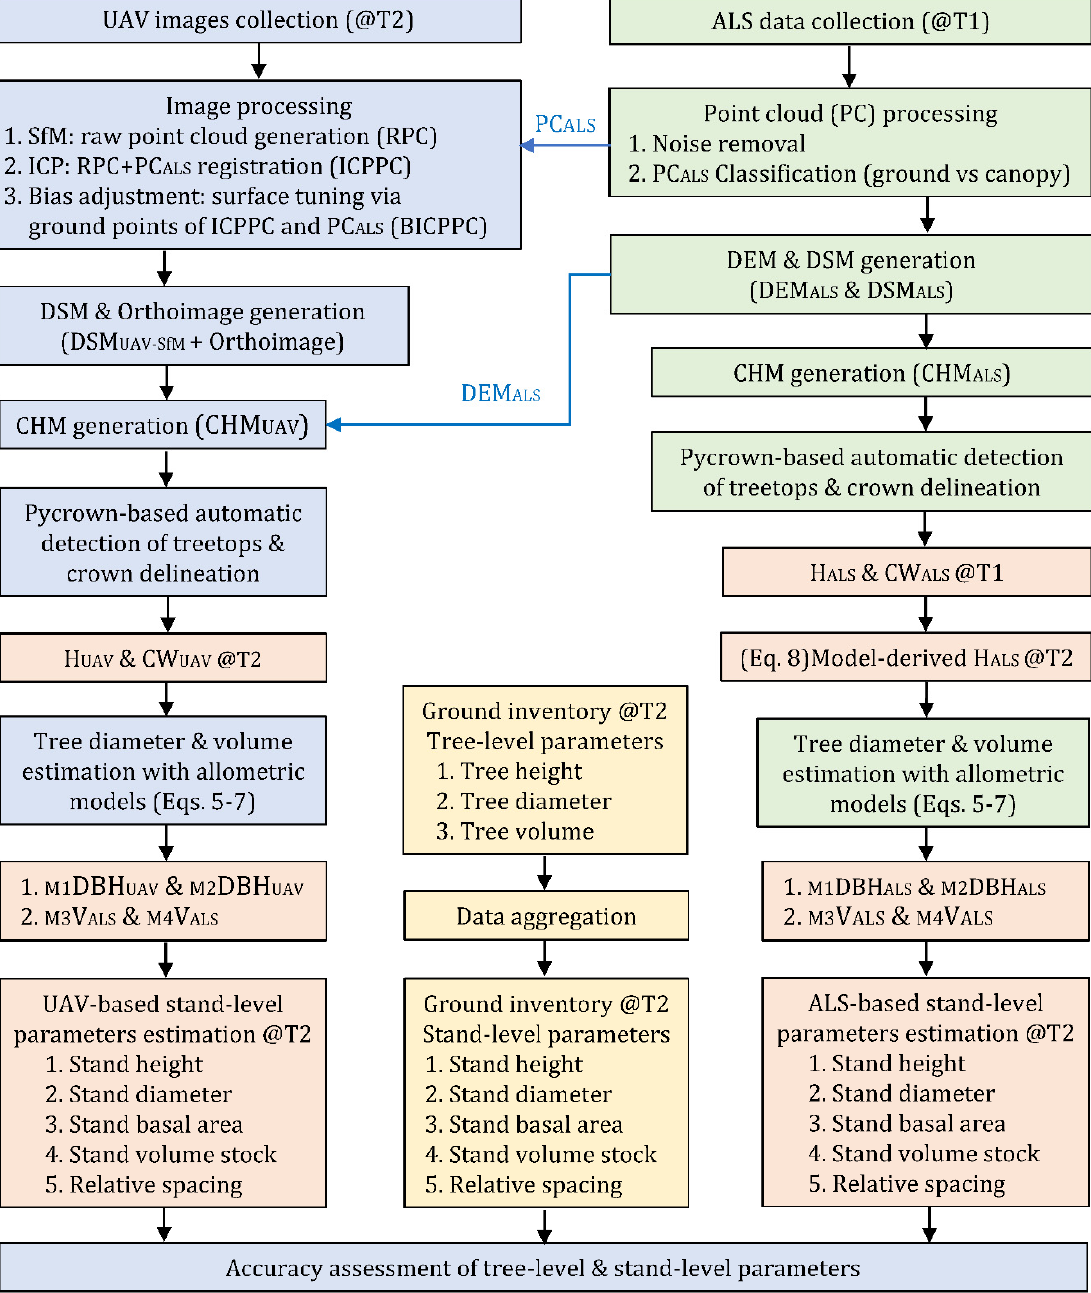
Figure 3. The flowchart of integrating ALS and UAV-SfM data for deriving tree-level volumetric parameters and stand density of forests. @T1 and @T2 indicate the acquisition year of the data, i.e., T1 = 2013 for the ALS data, and T2 = 2018 or 2019 for the UAV data of the Owase and Kameyama sites, respectively. See Table 1 for the details. The derived parameters of every single tree can be stored as a GIS layer based on tree identity and coordinates for advanced applications.